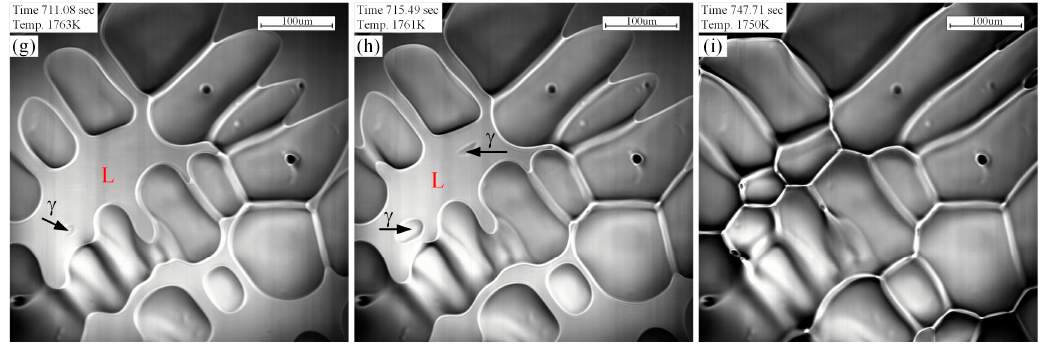
Figure 4. In-situ observation of phase transition in the mushy zone of steel Q345; from ( a ) to ( c ): L transforms into δ ; from ( d ) to ( f ): L and δ transform into γ ; from ( g ) to ( i ): L transforms into γ .